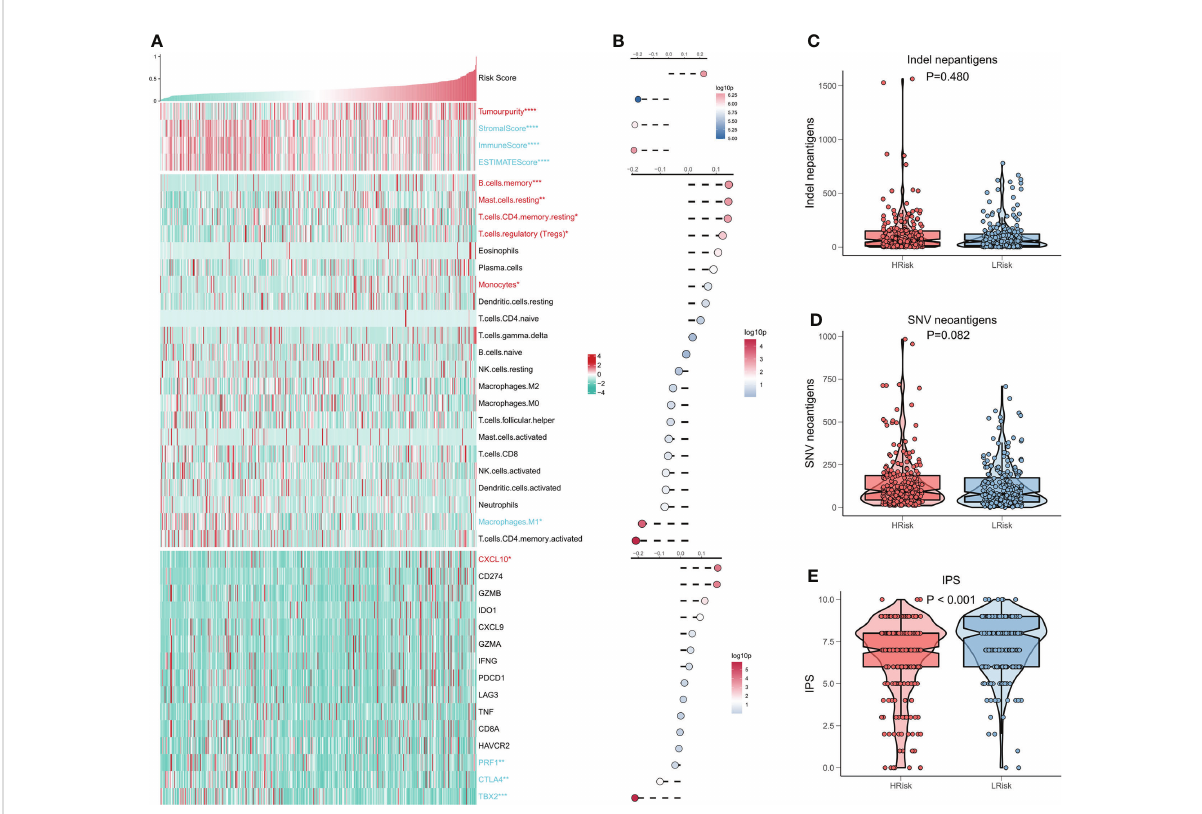
FIGURE 6 CRGs correlation deep learning model for immune in fi ltration analysis. (A) Heat map displaying the relationship of Risk score, Estimate score, immune cell in fi ltration abundance, and immune checkpoint table (B) From top to bottom: correlation analysis of Risk score and Estimate score, immune cell in fi ltration abundance, and immune checkpoint expression. (C) Box plot demonstrating the difference of indel neoantigens among both risk groups. (D) Box plot showing the difference of SNV neoantigens between the high-risk and low-risk groups. (E) Box plot demonstrating the difference in IPS among the high- and low-risk